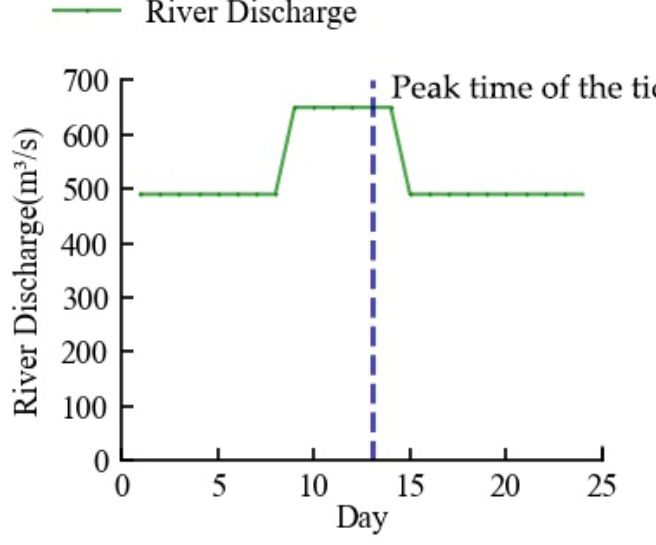
Figure 12. Practicable seawater suppression scheme.